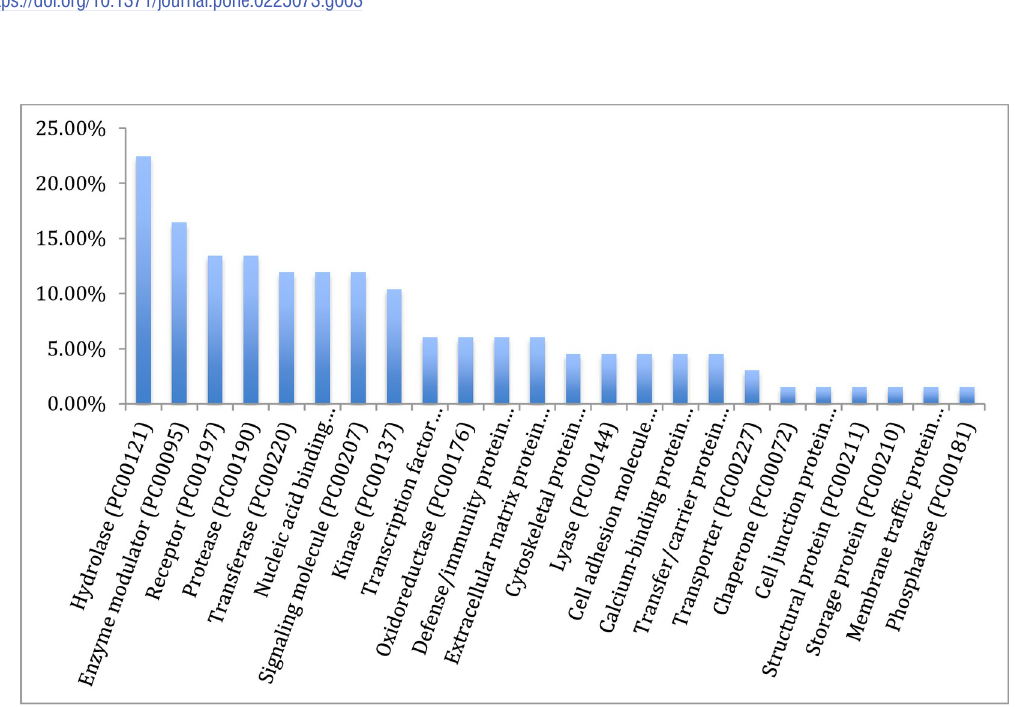
Fig 4. Gene ontology of the assembled transcripts of the Nile crocodile from the de novo transcriptome assembly showing the classification of the various protein transcripts.